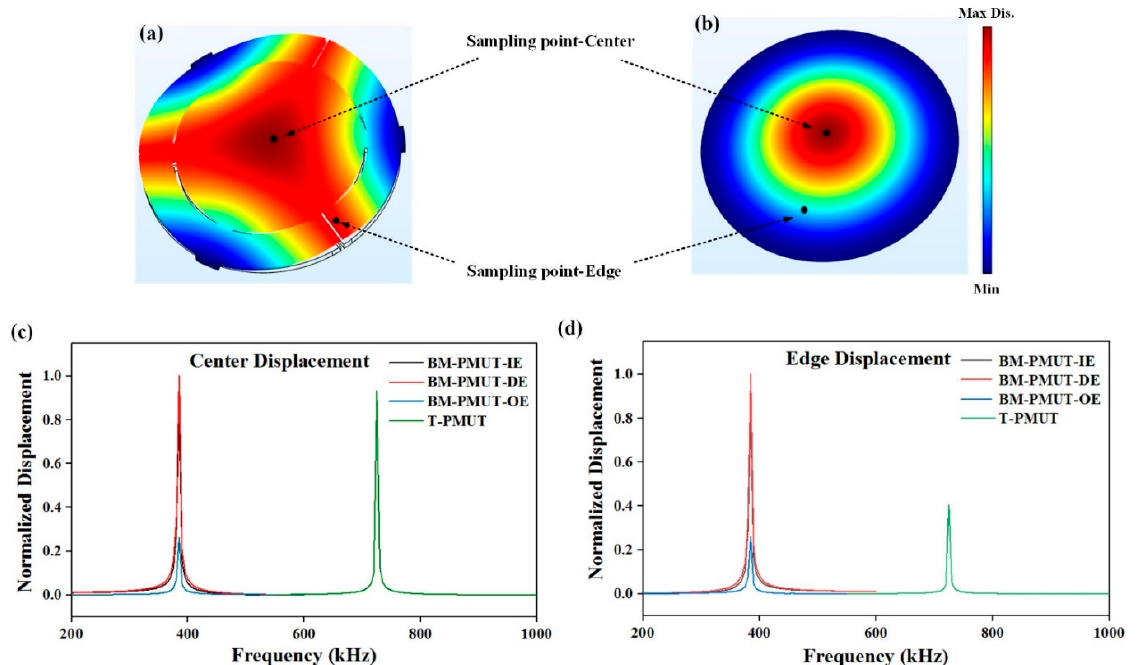
Figure 3. Simulated vibration mode shapes of ( a ) BM-PMUT and ( b ) T-PMUT. Simulated vibration displacement of ( c ) center and ( d ) edge in different structures.